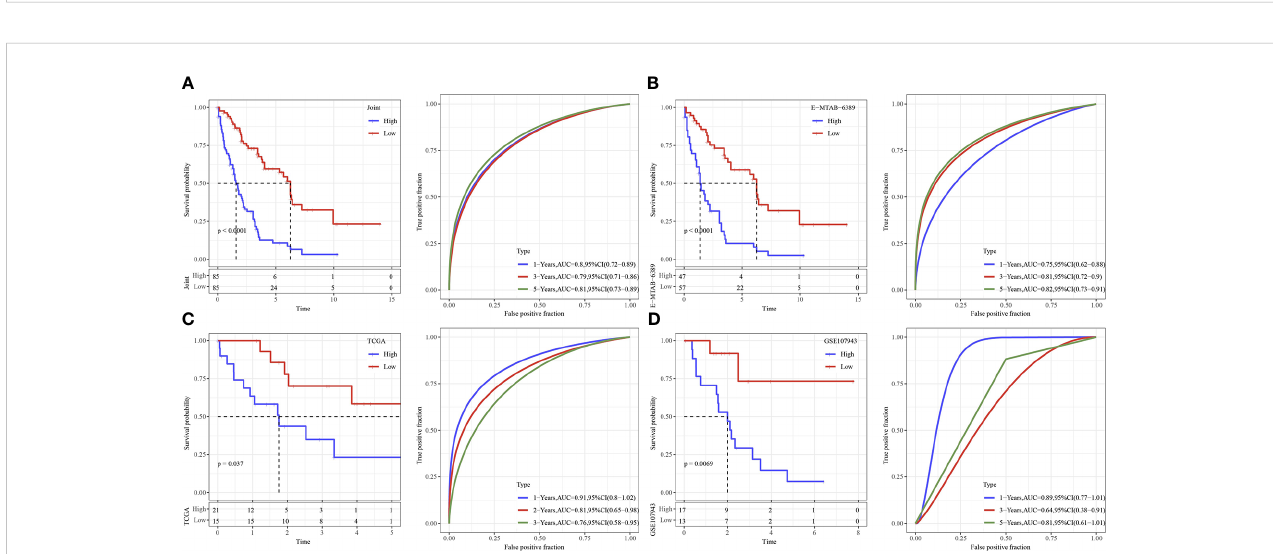
FIGURE 7 Validation of immune genes signature. (A) The KM curve and ROC analysis of RiskScore in Joint data. (B) The KM curve and ROC analysis of RiskScore in E − MTAB − 6389 dataset. (C) The KM curve and ROC analysis of RiskScore in TCGA dataset. (D) The KM curve and ROC analysis of RiskScore in GSE107943